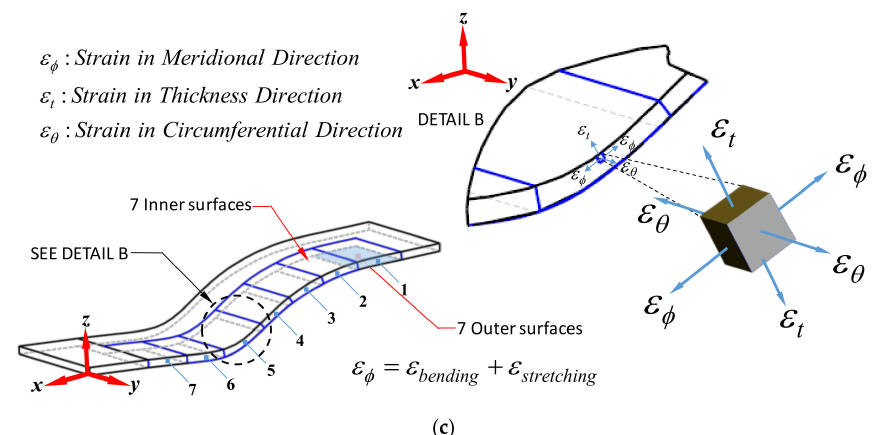
Figure 6. ( a ) and ( b ) Schematic of bending effects acting on the formed part during SPIF, and ( c ) strain deformations experienced by the metallic sheet.